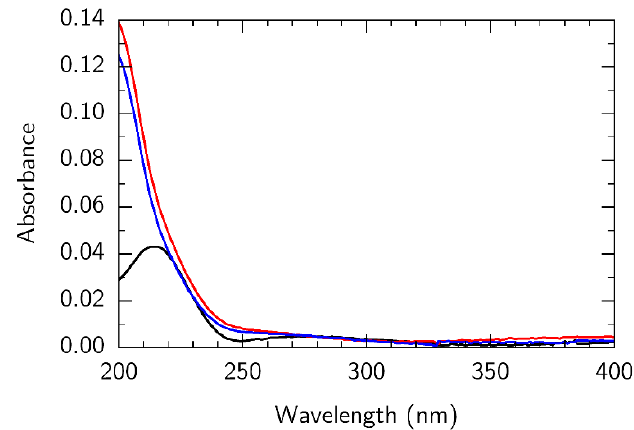
Figure 1. Optical absorption spectra of pristine PMMA/quartz (black line), DUV-exposed PMMA/quartz irradiated in air (red line), DUV-exposed PMMA irradiated in argon (blue line). PMMA film thickness, 0.25 μ m.